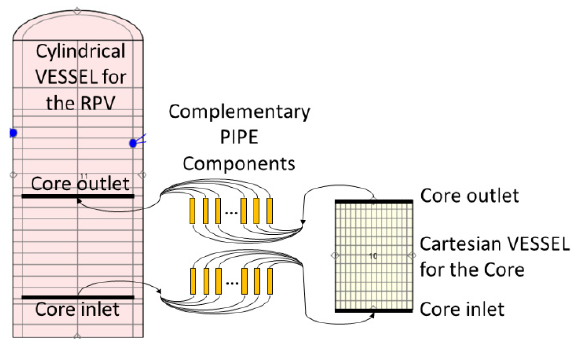
Figure 9. The complementary PIPE components between the two VESSELs.